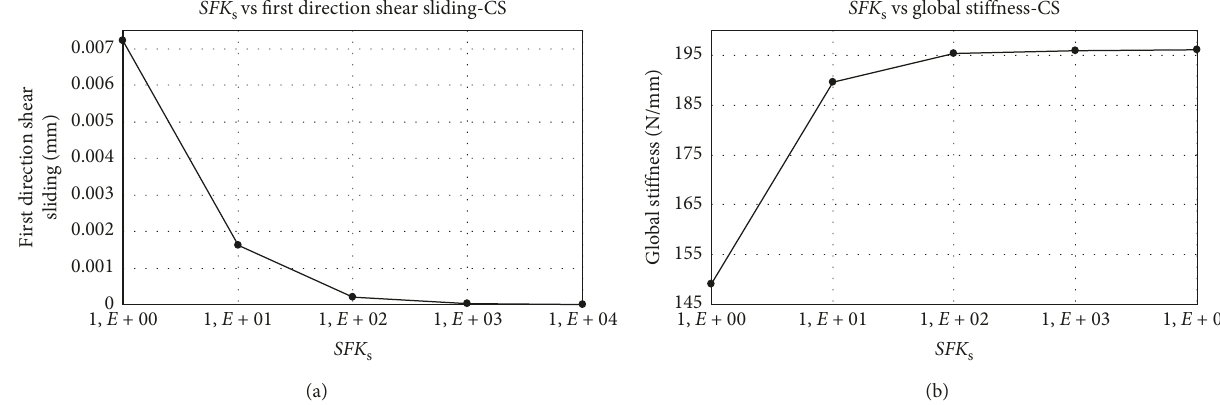
Figure 7: Sliding in first shear direction (a) and global stiffness (b) as a function of k